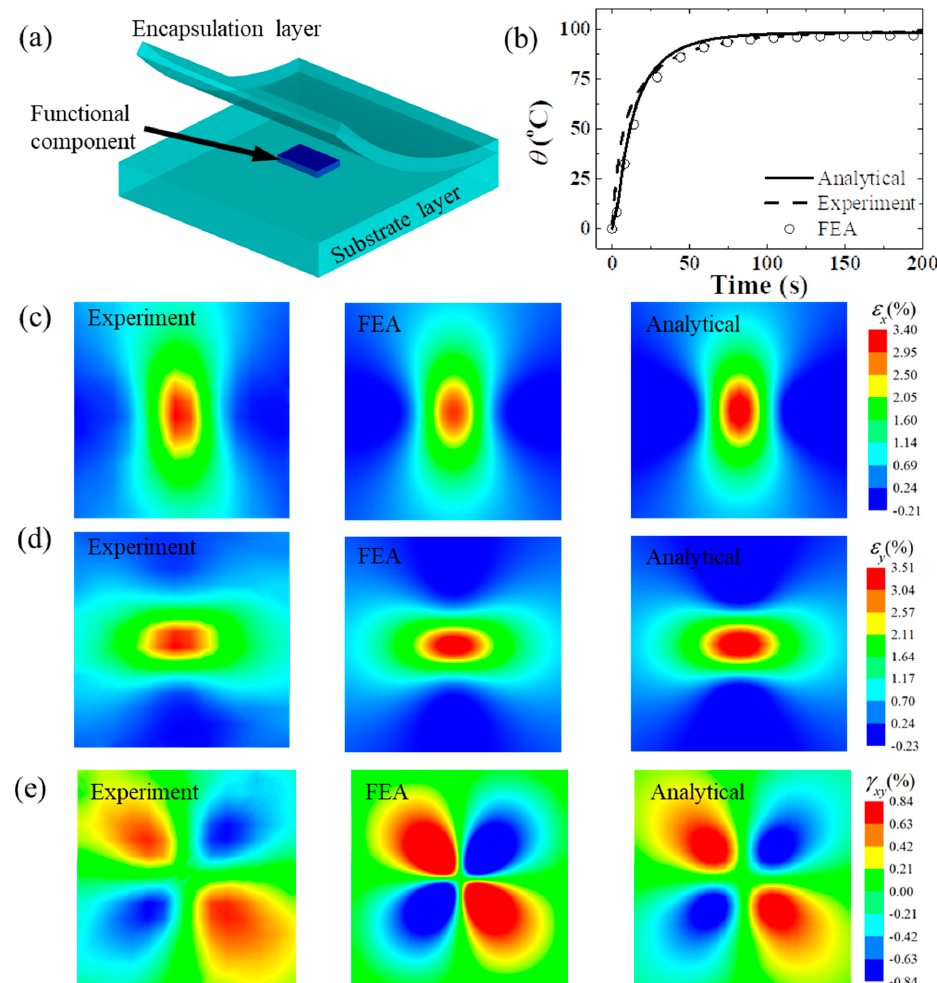
Figure 4. ( a ) Schematic diagram of a flexible electronic device consisting of a functional component on a substrate encapsulated by an encapsulation layer [69]. ( b ) The temperature increase versus time at the center point on the top surface. [69]. The comparisons of ( c ) x -stain, ( d ) y -strain and ( e ) shear strain from experiments, finite element analysis (FEA) and analytical model